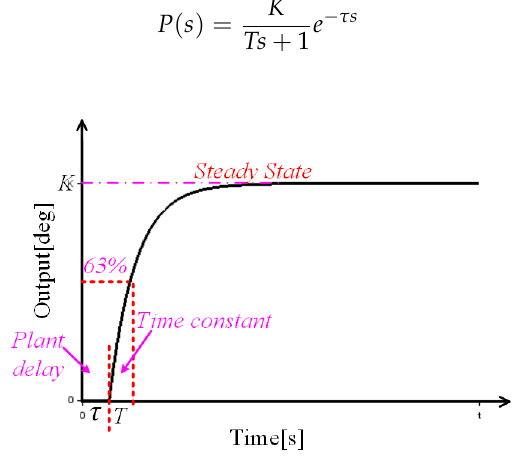
Figure 2. Step response of FOPTD plant.